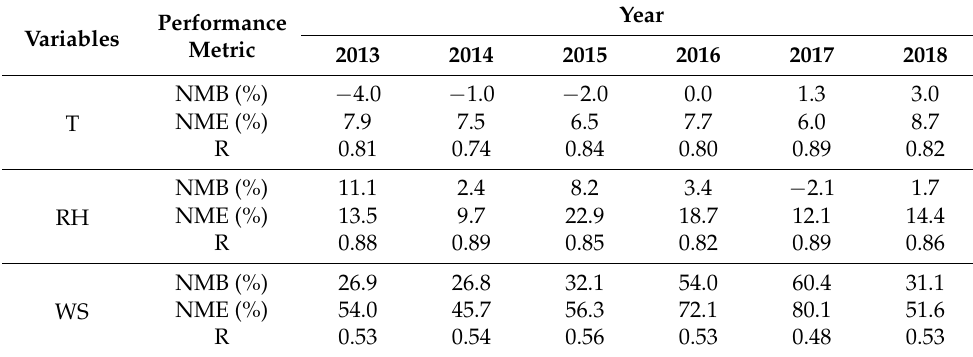
Table A2. Performance statistics of meteorological variables simulation results.